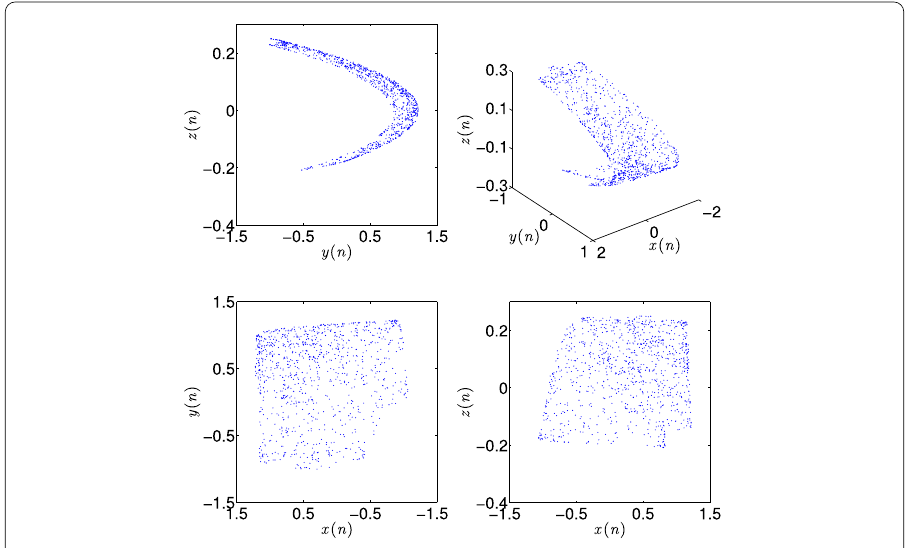
Figure 2 Phase portraits of the fractional-order Stefanski map with υ =